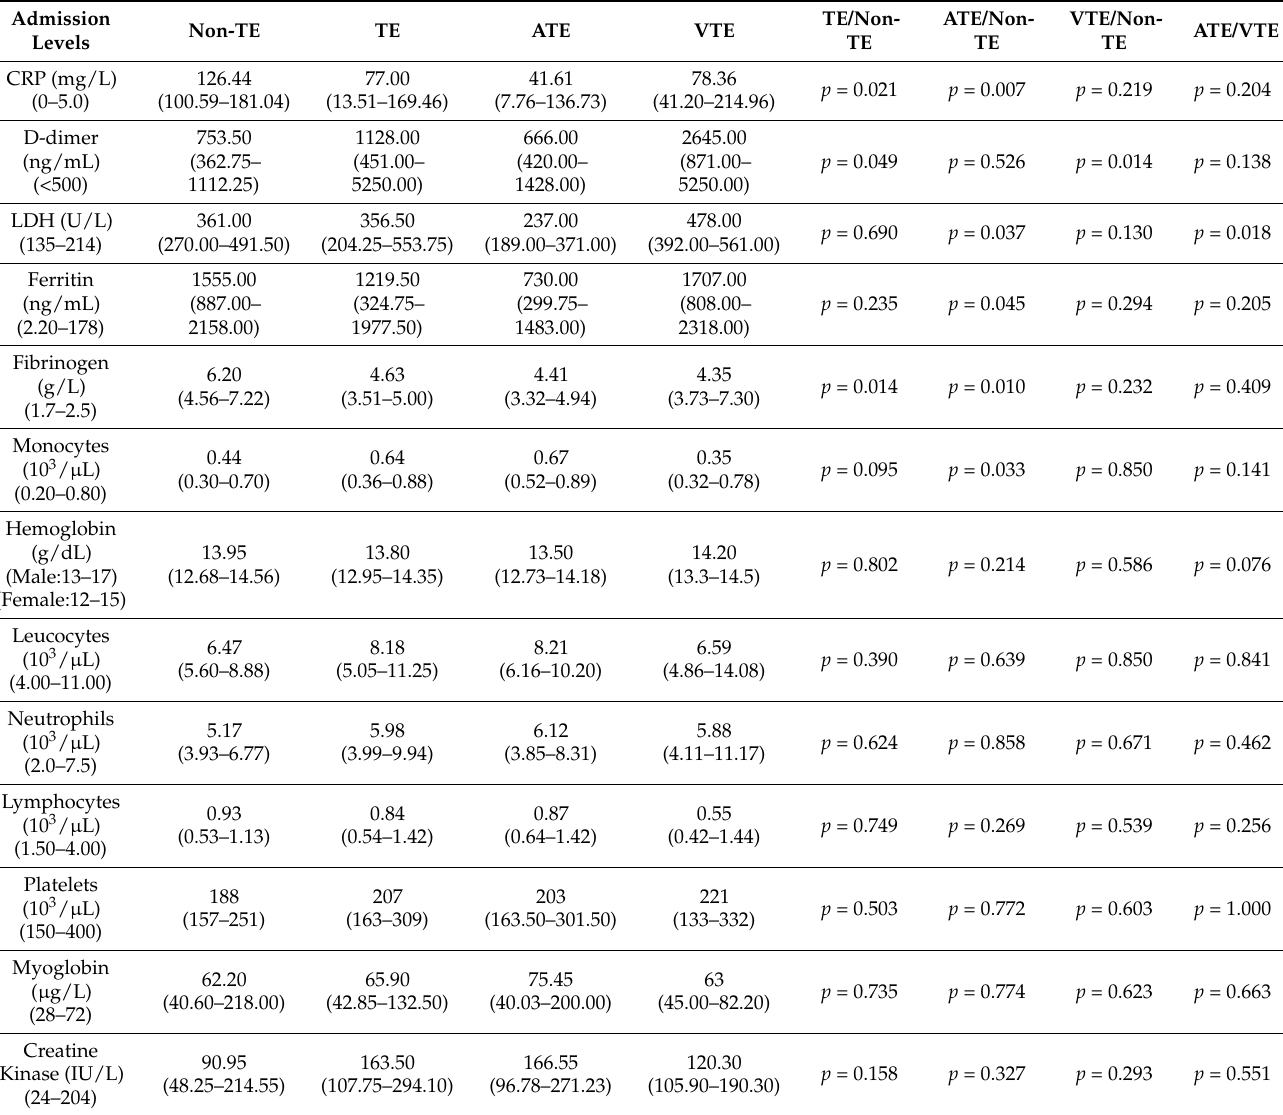
Table 3. Laboratory parameters (median values and interquartile range) upon hospital admission and comparison between groups of patients. Units and reference range are presented next to each parameter, on the left column. Comparisons were conducted using the Kruskal–Wallis H test. A p value of <0.05 was considered statistically